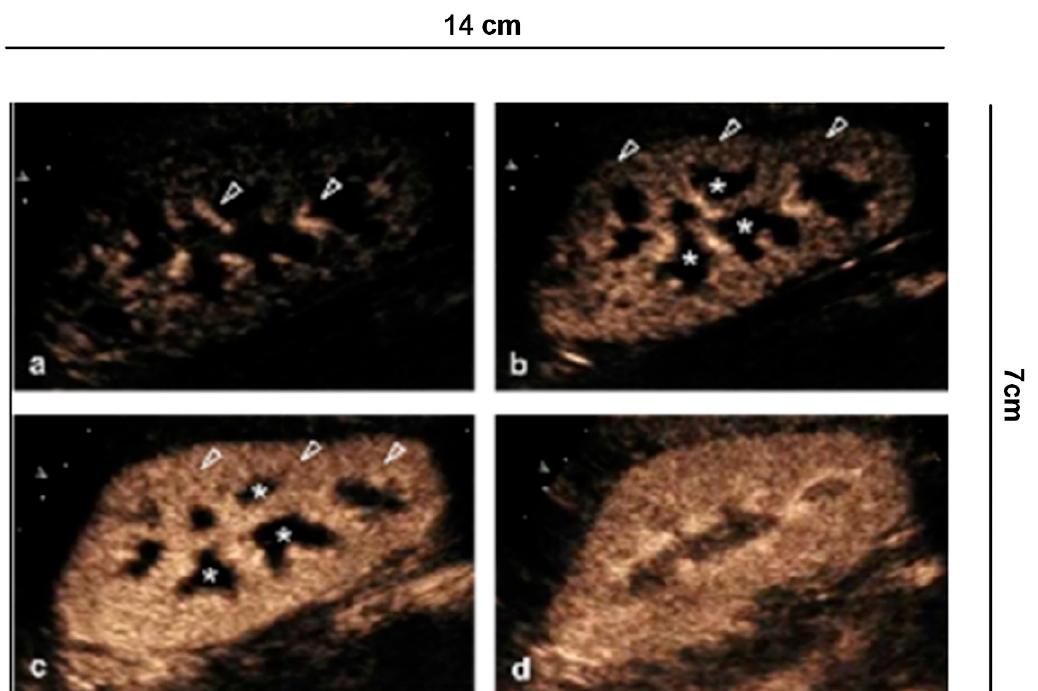
Figure 1. Renal vascularity with CEUS. ( a ) A few seconds after injection of the contrast medium, the microbubbles arrive in the arterial branches of the pedicle and in the branches of the interlobar artery (arrowhead). ( b ) After 15 s the cortical phase begins (arrowhead) without involving the medulla (asterisk). ( c ) After the completion of the cortical phase (arrowhead) comes the onset of the parenchymal phase (25 s–4 min) with progressive appearance of the enhancement of the external medulla (asterisk) and ( d ) subsequent involvement of the pyramids.